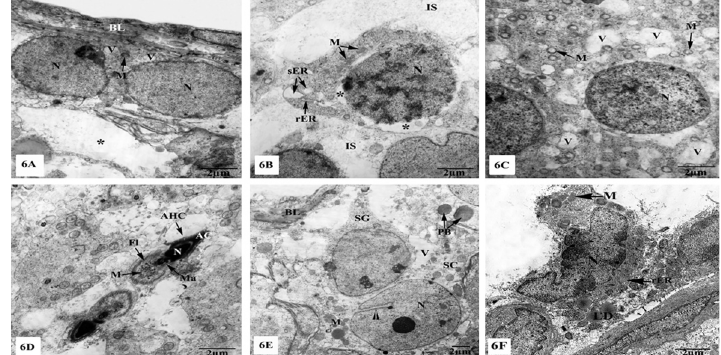
Figure 6. Electron micrographs of the testes of taxol (TXL)-treated rats showing ( A ) deteriorated spermatogonia resting upon thickened basal lamina (BL) and have few electron-dense mitochondria (M), cytoplasmic vacuoles (V), and marked dilatations of intercellular spaces (asterisks); ( B ) atrophied primary spermatocyte with karyorrhexed nucleus (N) separated from the cytoplasm leaving empty zones (asterisks), few electron-dense M, fragmented rough endoplasmic reticulum (rER), and dilated smooth endoplasmic reticulum (sER), as well as widened intercellular spaces (IS); ( C ) degenerated rounded spermatids appeared with karyorrhexed N and cytoplasm with few M and large V; ( D ) atrophied elongated spermatids having distorted acrosomal head caps (AHC), electron-dense N, condensed acrosomes (AC), electron-dense small manchettes (Ma), and short fl agella (Fl) with disarranged electron-dense M; ( E ) deformed Sertoli cell separated from the basal lamina (BL) and has irregular N with deep nuclear indentation ( c ), electron-dense M, phagosomal bodies (PB) and V. Club-shaped spermatogonium (SG) is also markedly detected; ( F ) apoptotic Leydig cell revealing highly irregular and fragmented N and degenerated cytoplasm having lipid droplets (LD), electron-dense M, and fragmented rER. Scale bar 2 m